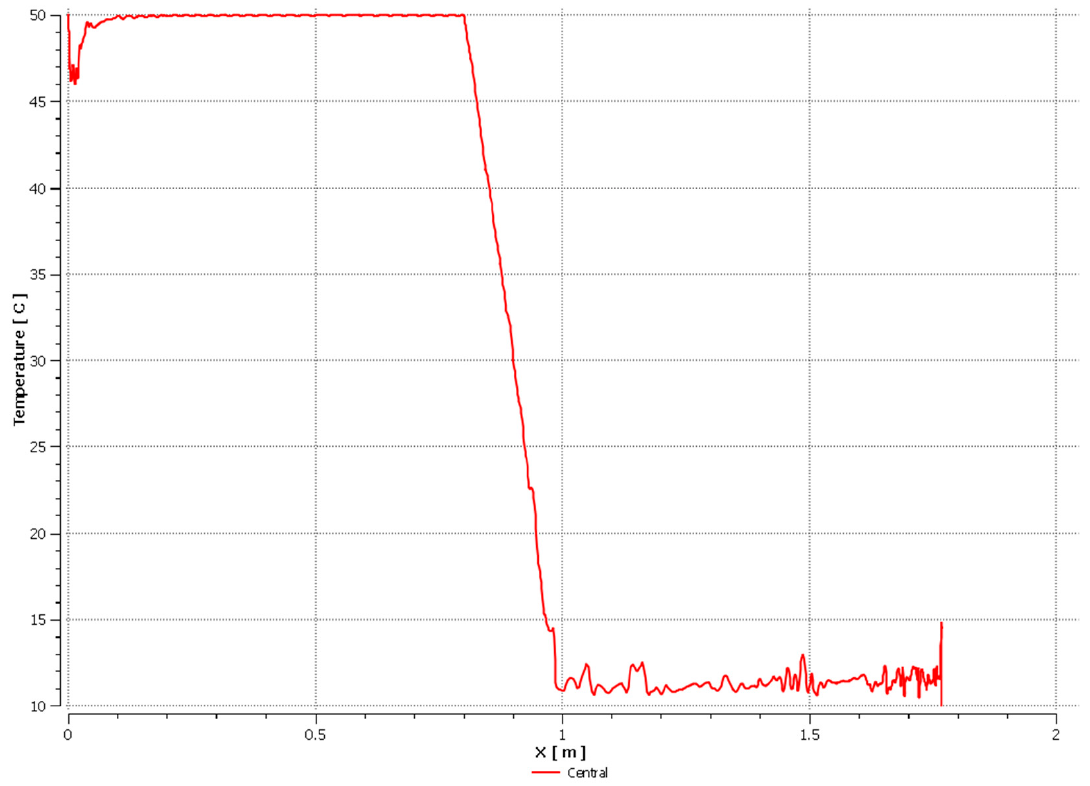
Figure 16. Temperature distribution along the height of the heat pipe’s wall.